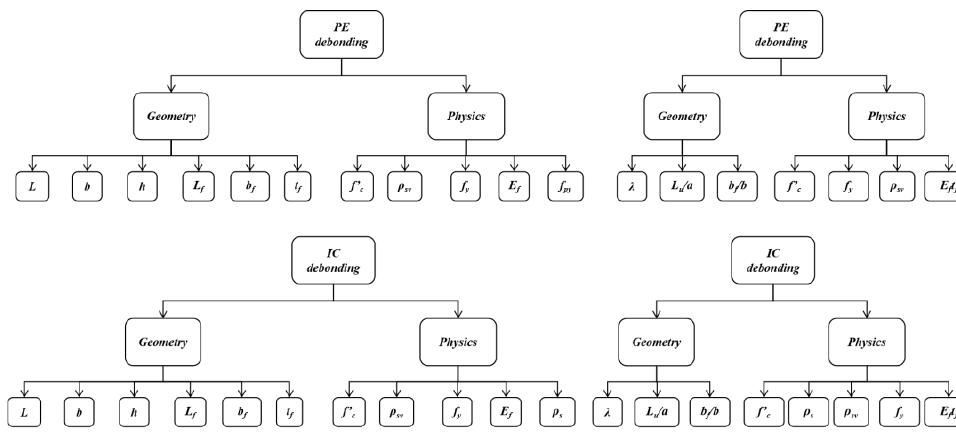
Figure 2. Primary indicator system.